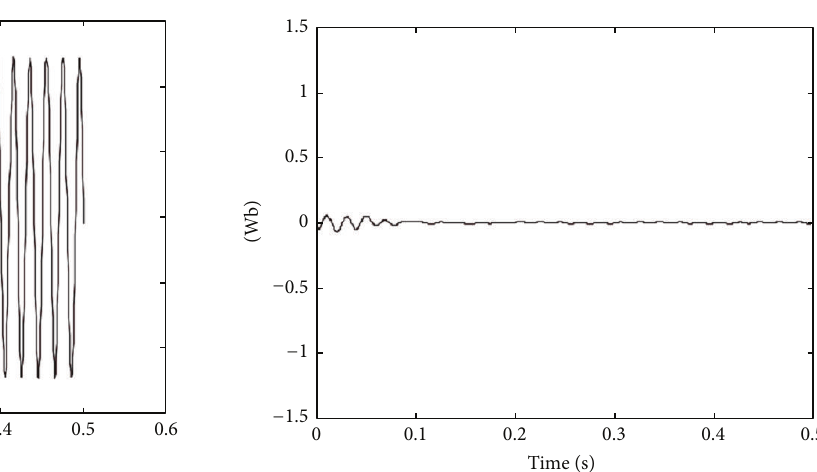
Figure 5: Estimated flux ̂𝜑 𝑏 .